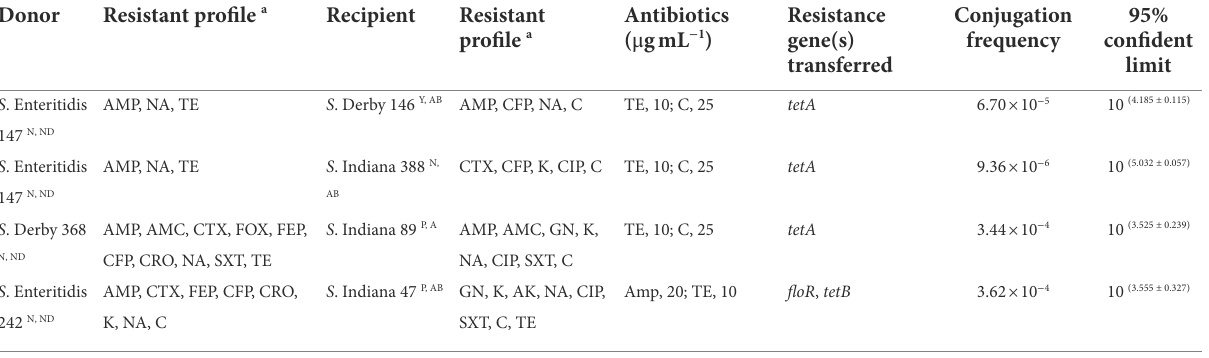
TABLE 3 The conjugation frequency of four Salmonella